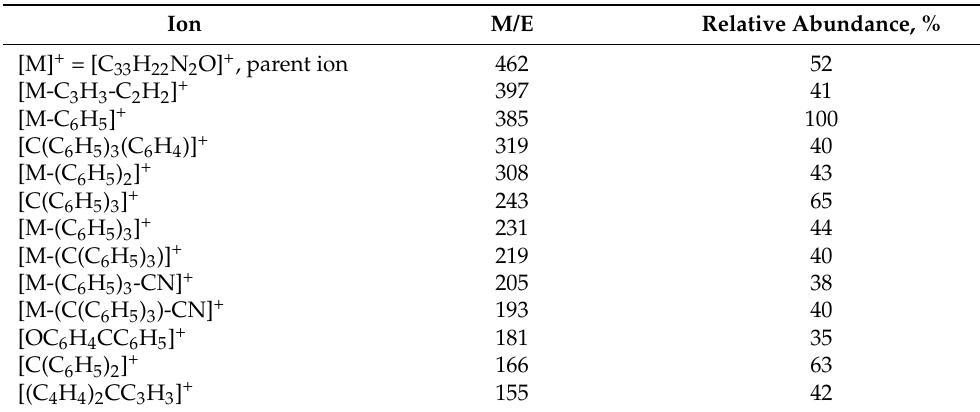
Table 4. Most intensive ions in mass spectrum of TPPN recorded during the GED experiment at 478 K (U ioniz = 50